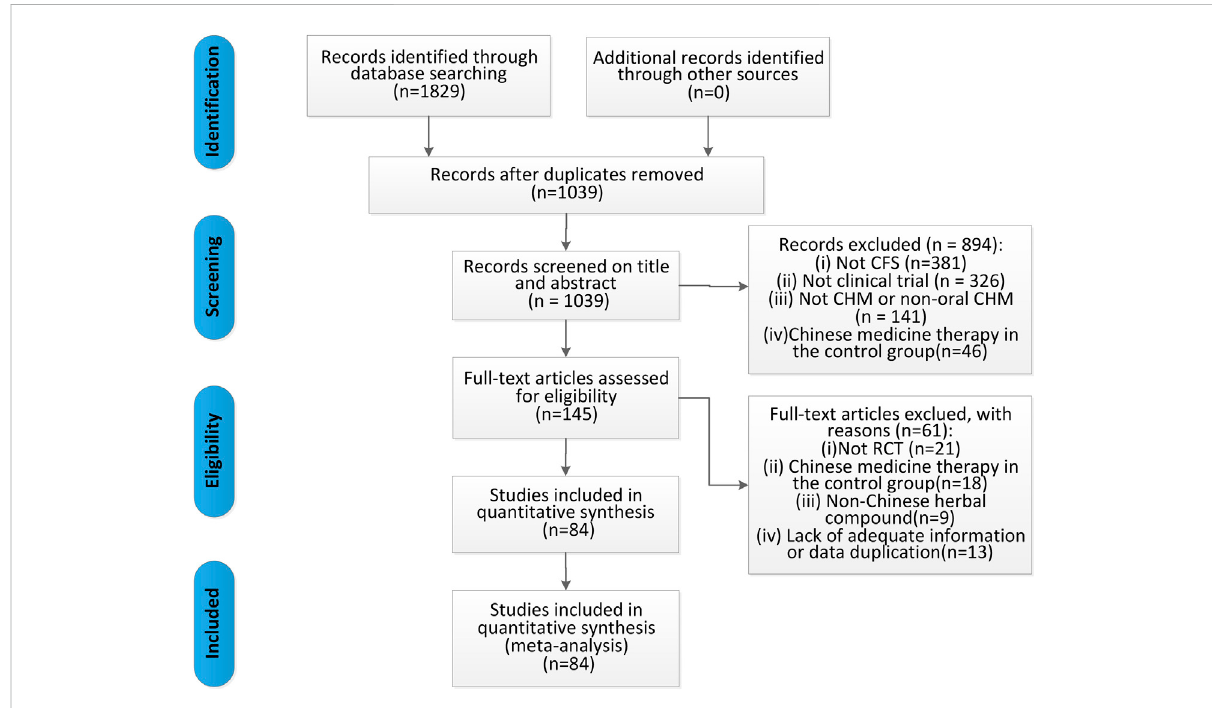
FIGURE 1 Flow diagram of the studies selection